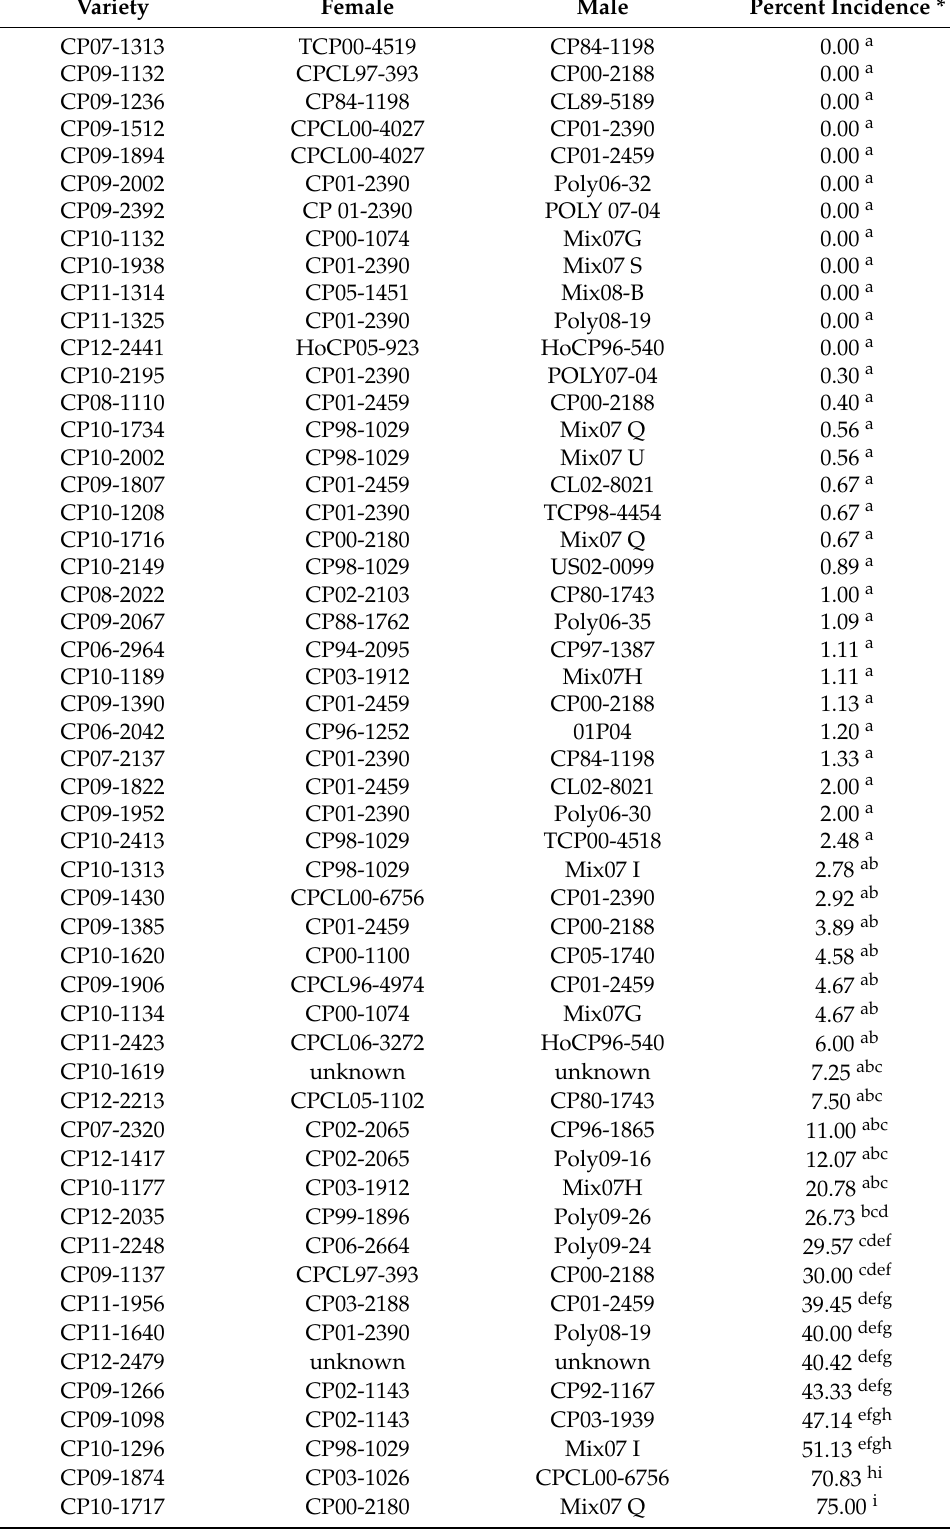
Table 3. Mean percent incidence of sugarcane yellow leaf virus in primary and secondary seedcane increases from 2015 to